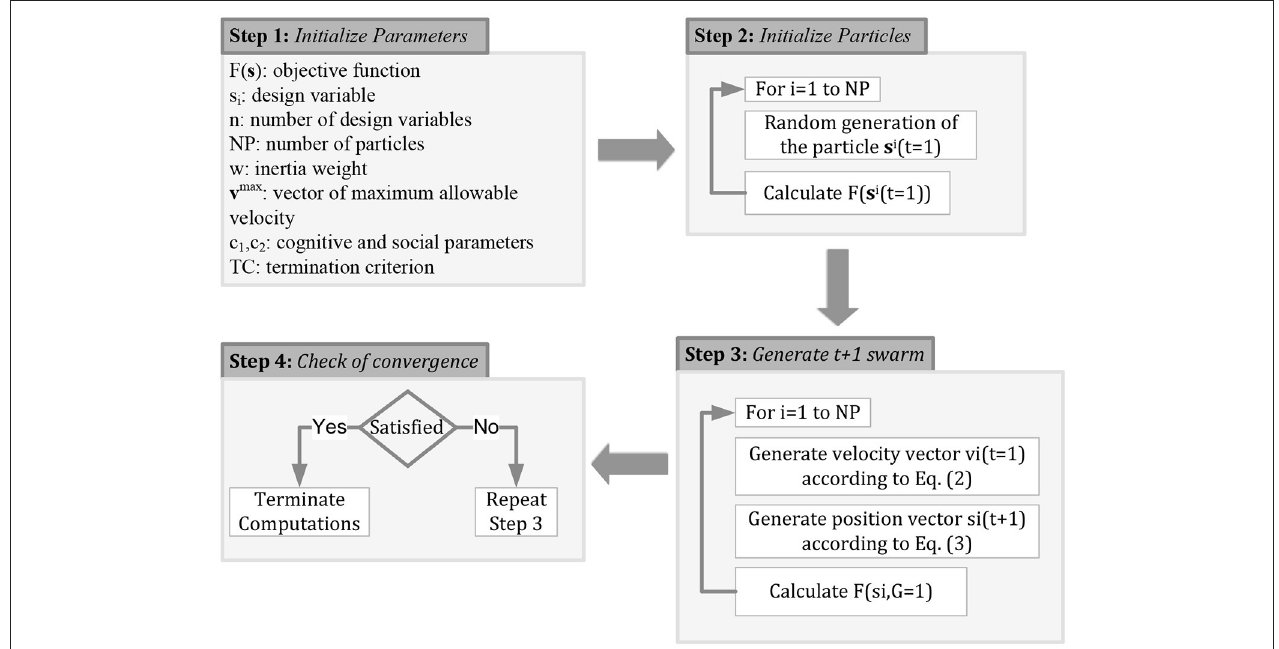
FIGURE 1 | Schematic representation of PSO algorithm.